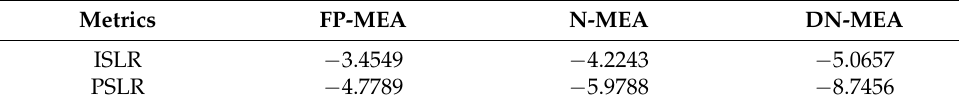
Figure 8. Azimuth profiles of the corner reflector imaging results: ( a ) original results; ( b ) local am- plification. Table 3. Quality assessment metrics. Table 3. Quality assessment metrics.